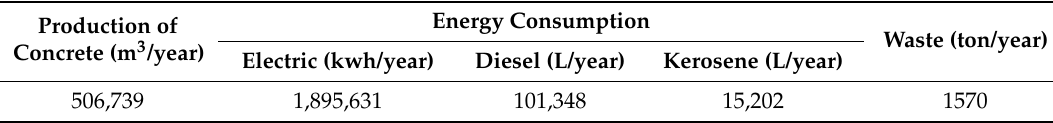
Table 6. Energy consumption of manufacturing process.